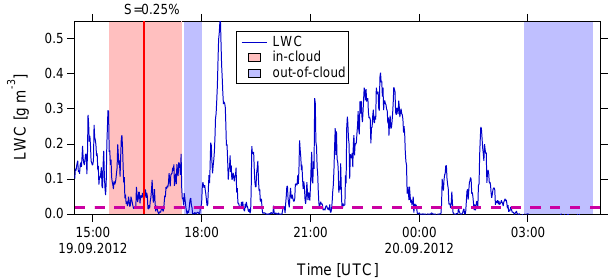
Figure 1. Time series of the liquid water content (LWC) measured by a particle volume monitor permitting distinction between in- cloud and out-of-cloud conditions. The time period for in-cloud conditions, during which the cloud supersaturation was investi- gated, is marked in red (19 September 2012, 15:26–17:17UTC). The red vertical line indicates the time when the CCN scan at S = 0.25% was finished. Out-of-cloud conditions are marked in blue, in which the first small time period was used to apply the SMPS method (19 September 2012, 17:30–18:00UTC). The sec- ond larger period (20 September 2012, 02:54–04:47UTC) was used for the CCN method, because a longer time interval without cloud was needed to get a full CCN